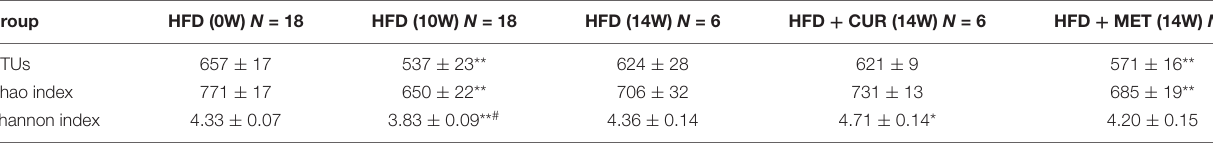
TABLE 1 | The abundance of OTUs, Chao1 index and Shannon index in each